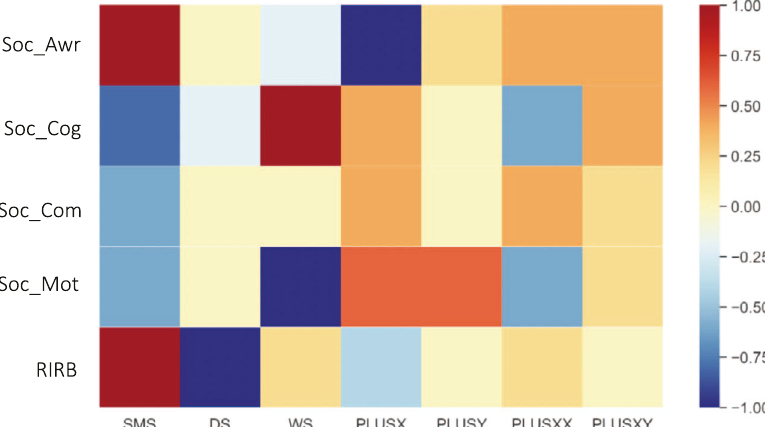
Fig. 6 Feature importance for the LASSO model with IQ included. The coloring represents both the feature importance and the direction of feature effect. Positive values indicate an increased likelihood of a certain GDD group while negative values suggest a reduced probability of a certain GDD group. Higher absolute values (i.e., feature importance values) indicate greater consistency of a feature being selected as an important predictor to improve prediction accuracy across the 5-fold cross-validation. Awareness is consistently selected as an important predictor for SMS and PLUSX. Cognition is consistently selected for predicting SMS and WS. Motivation is consistently selected for predicting WS, PLUSX, and PLUSY. RIRB is consistently selected for predicting SMS and